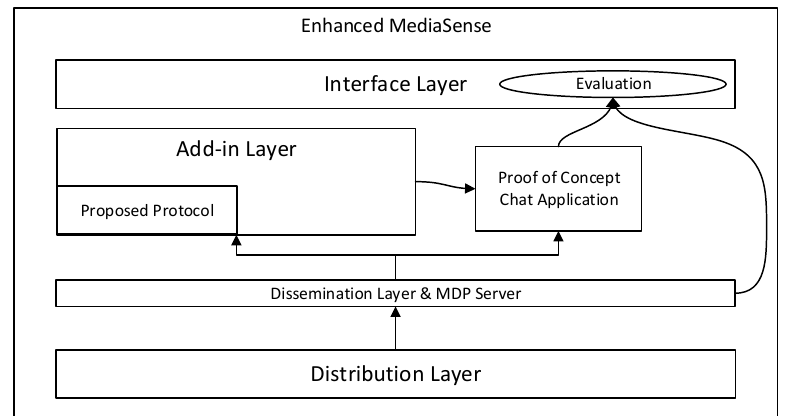
Figure 6. Enhanced MediaSense Architecture.